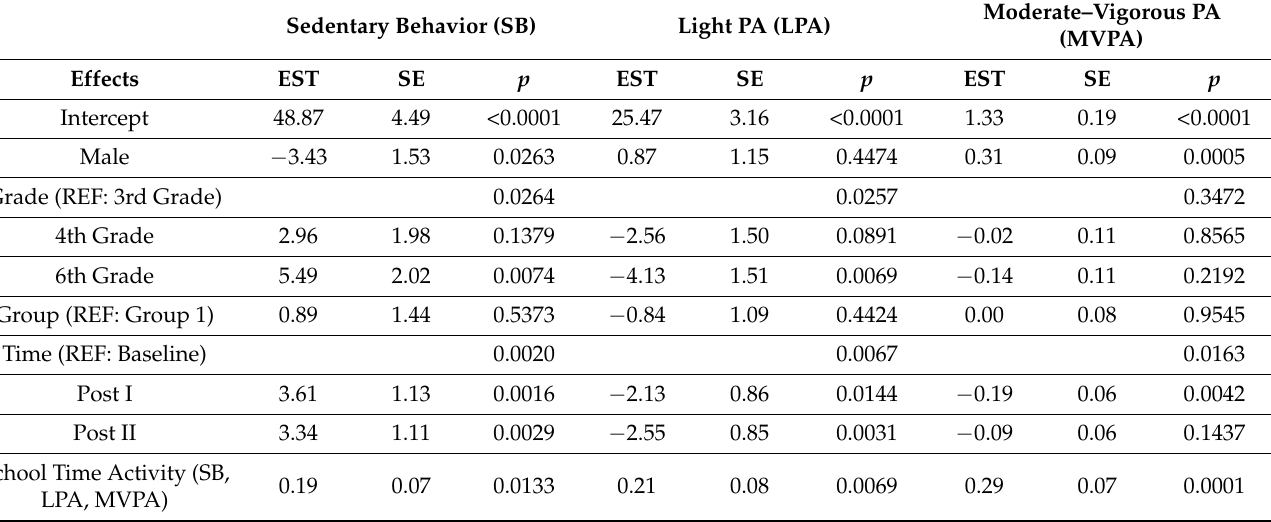
Table 5. Results from a mixed-effects model assessing interactions between sex, grade, desk assign- ment, time, and in-school activity on after-school SB, LPA, and MVPA. Sedentary Behavior (SB) Light PA